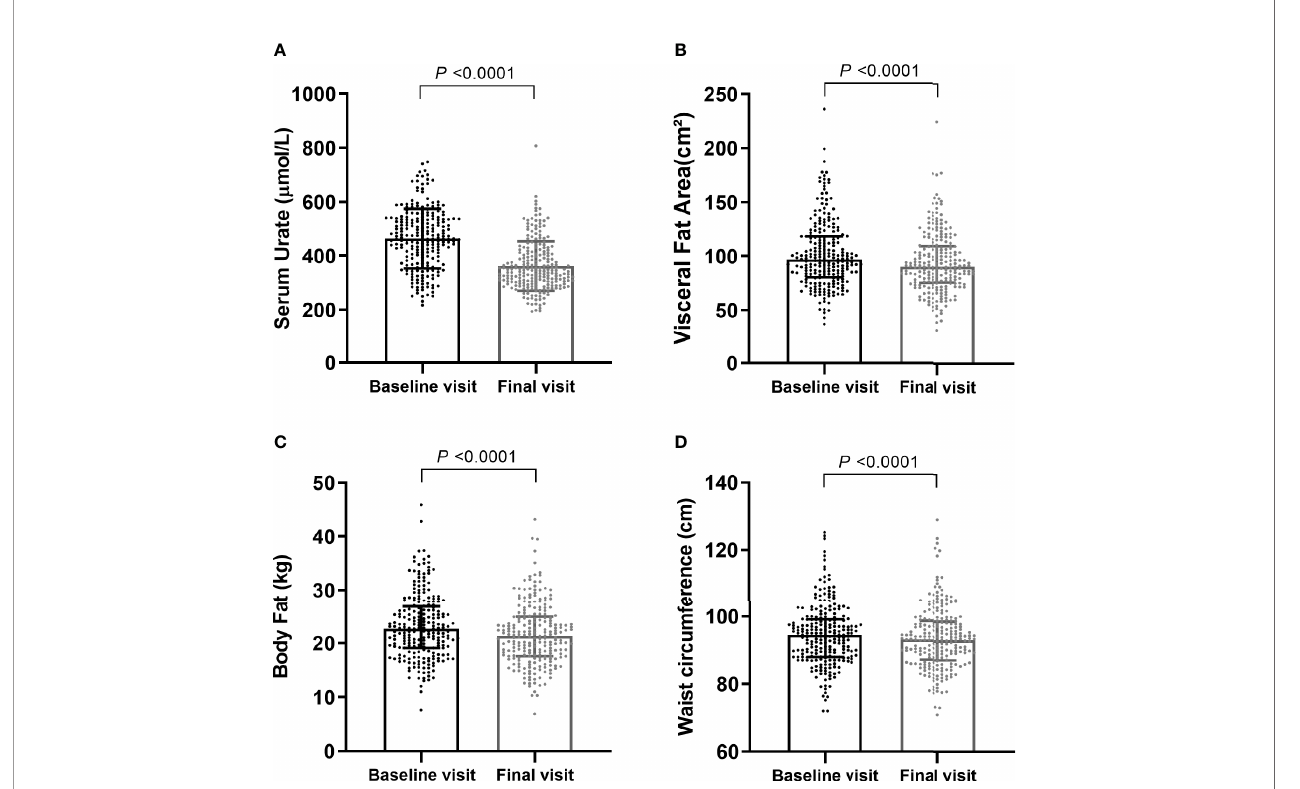
FIGURE 2 | Comparisons of main characteristics after urate-lowering. Serum urate levels (A) were shown as Mean ± SD, visceral fat area (B) , body fat (C) , and waist circumference (D) were shown as Median (IQR 25th-75th). P values were calculated by paired-sample t-tests or Wilcoxon Rank tests as appropriate.